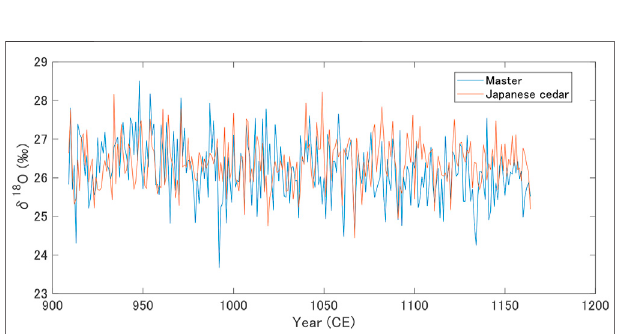
FIGURE 2 | Oxygen isotope ratio ( δ 18 O) of the master chronology (Nakatsuka et al., 2020; ITRDB, https://www.ncei.noaa.gov/access/paleo- search/study/28832) and Japanese cedar (this study, showed in cross- dated age).